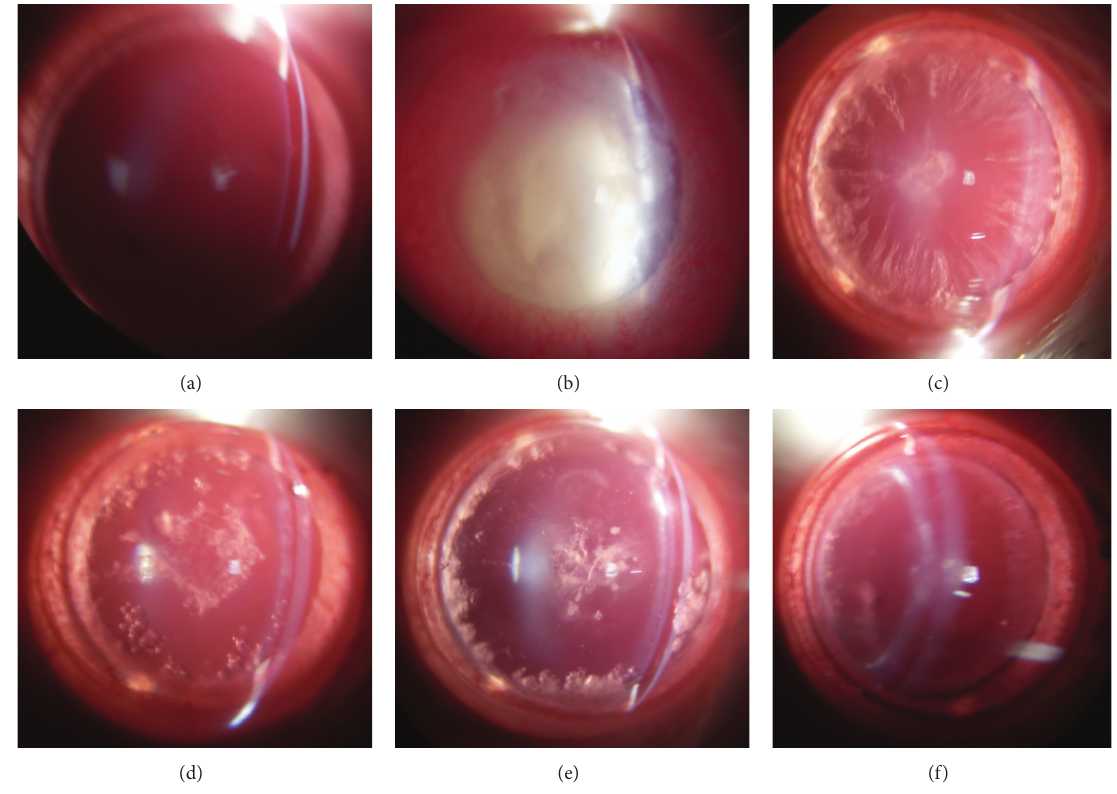
Figure 2: Inhibitory effect of rHV3 eye drops on STZ-induced diabetic cataracts in Sprague-Dawley rats. Representative photographs of lens from each group at the end of four weeks rHV3 eye drops treatment. (a): normal control (group A); (b): diabetic cataracts untreated (group B); (c): diabetic cataracts treated with 50 𝜇 L (one drop) of 0.053 𝜇 g/ 𝜇 L pirenoxine sodium eye drops each time (group F); (d), (e), and (f): diabetic cataracts treated with 50 𝜇 L (one drop) of 0.5, 1, 2 ATU/ 𝜇 L rHV3 eye drops each time, respectively (groups C, D, E). The drug was administrated 3 times per day for four weeks.